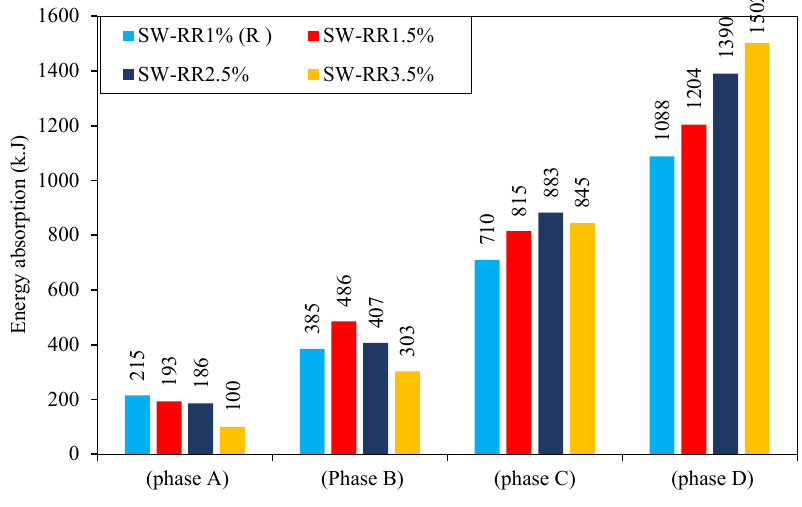
Figure 12. Energy absorption of group 1.